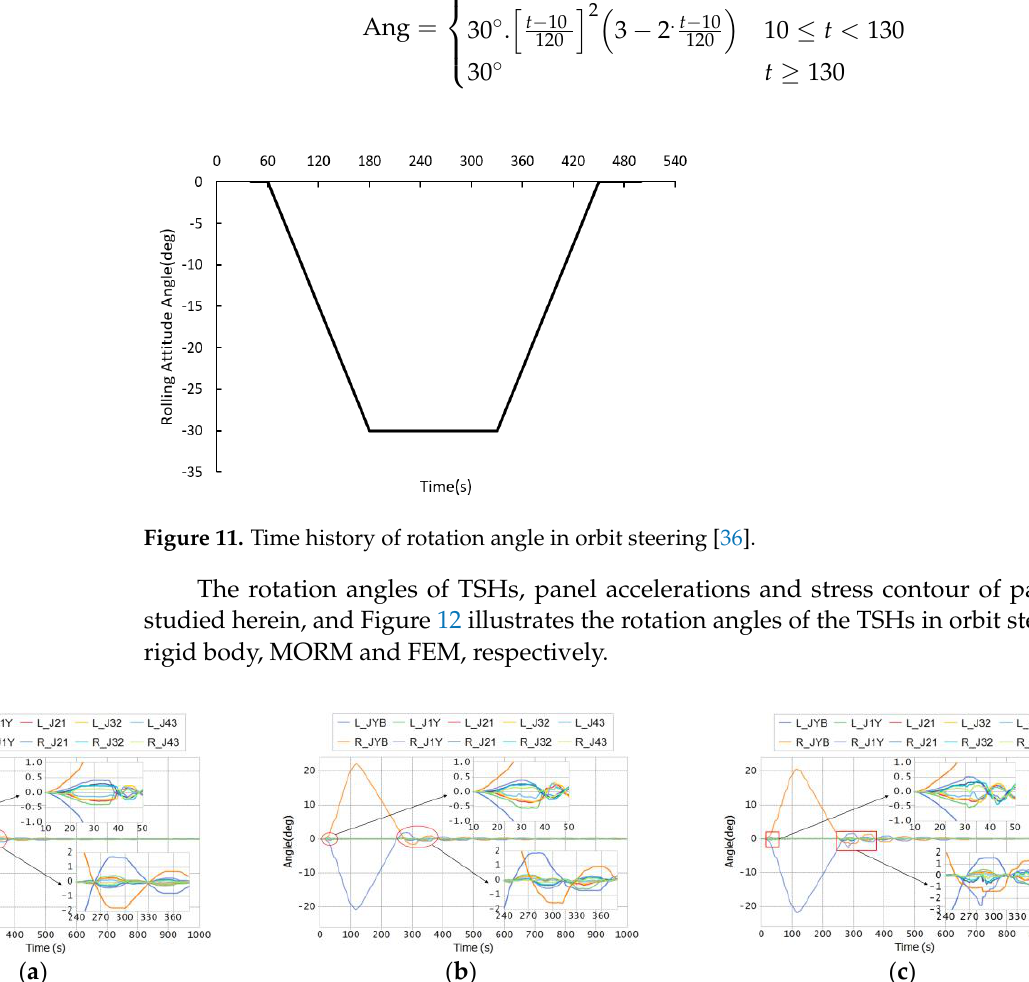
11 of 15 deployed status, the deployed panels might rotate small angles around TSHs. The driving torques generated by these rotation angles might affect the orbit-attitude control system.